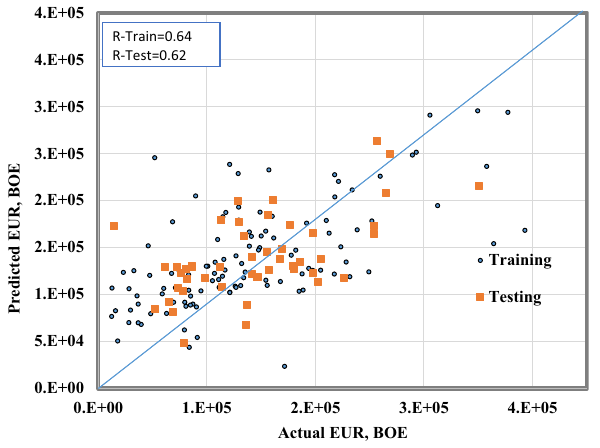
Fig. 4 The actual EUR values versus the estimated values from the LR model without including IP30 in the input data for the training set and the testing data set